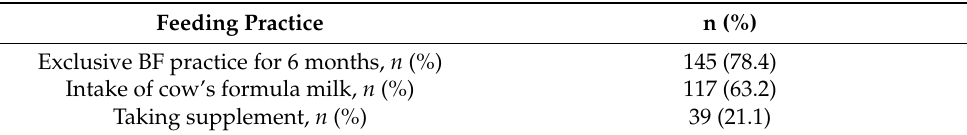
Table 2. Feeding practice of children aged 6–36 months ( n = 185). Feeding